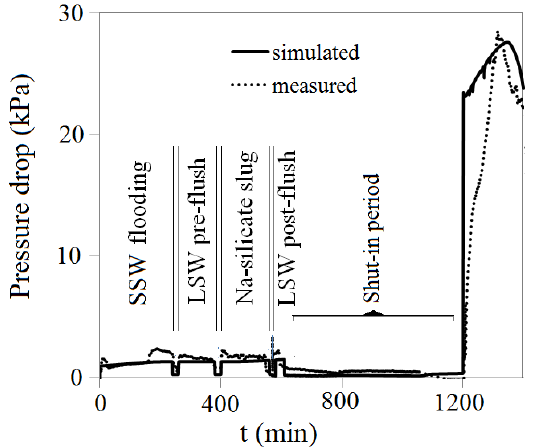
dual-permeability sand-pack flooding